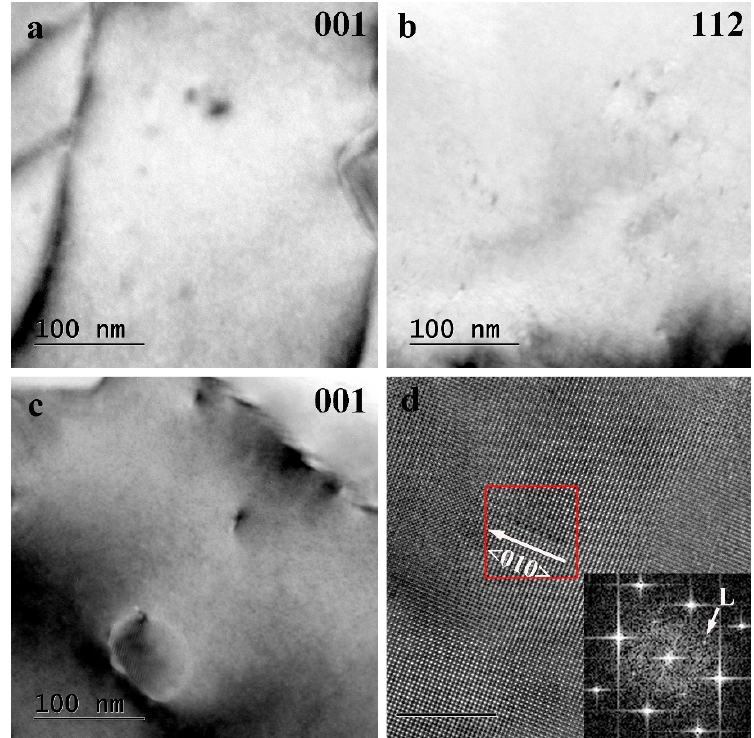
Figure 9. TEM bright-field images of the weld nugget zone (WNZ) along different zone axis: ( a ) on the 7A52 side along <001> Al zone axis; ( b ) on the 7A52 side along <112> Al zone axis; ( c ) on the 6061 side with the beam parallel to the <001> Al zone axis; ( d ) High-resolution TEM images and corresponding FFT patterns of L precipitate in ( c ) with the beam parallel to the <001> Al zone axis.